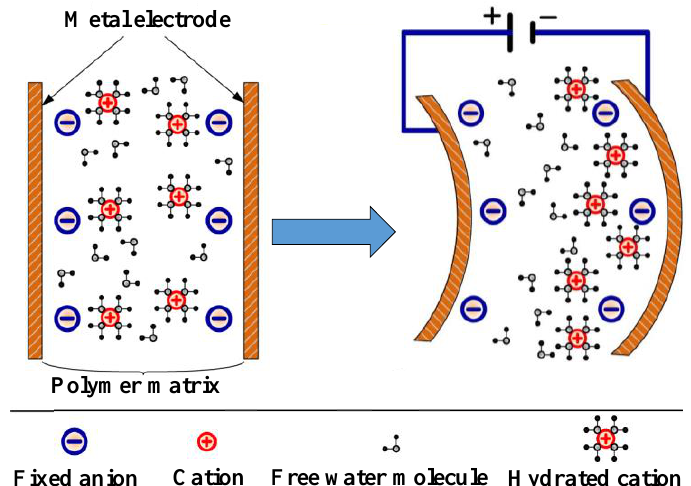
Figure 1. Illustration for ionic migration and deformation of IPMC.